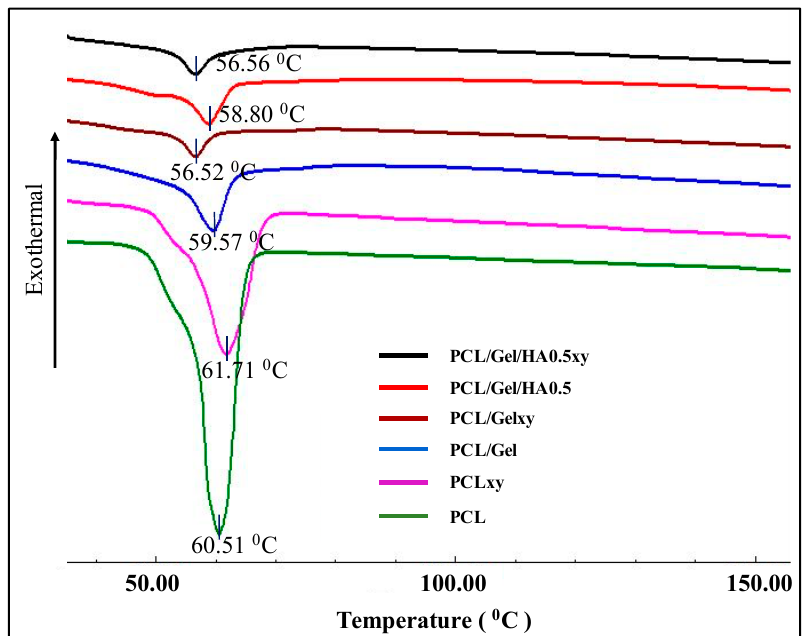
Figure 5. DSC thermograms of PCL, PCLxy, PCL/Gel, PCL/Gelxy, PCL/Gel/HA, and PCL/Gel/HAxy.